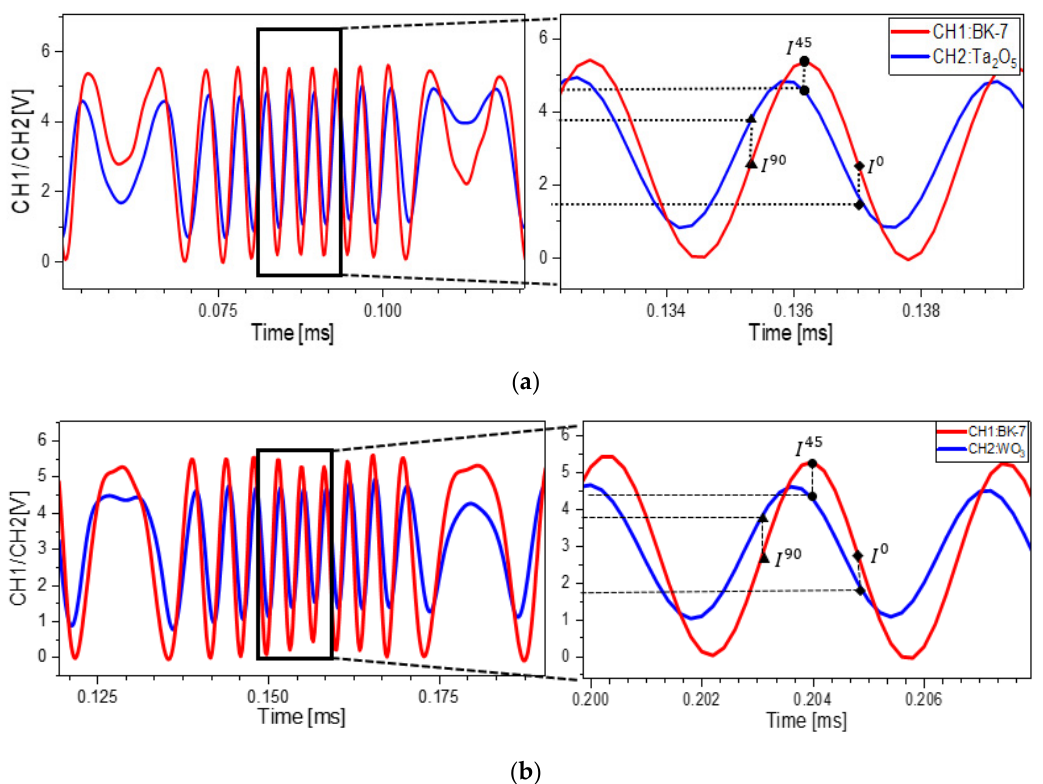
Figure 5. Output light intensities of the reference and sensing arms with single-layer deposited films of ( a ) Ta 2 O 5 and ( b ) WO 3 placed in the proposed system.